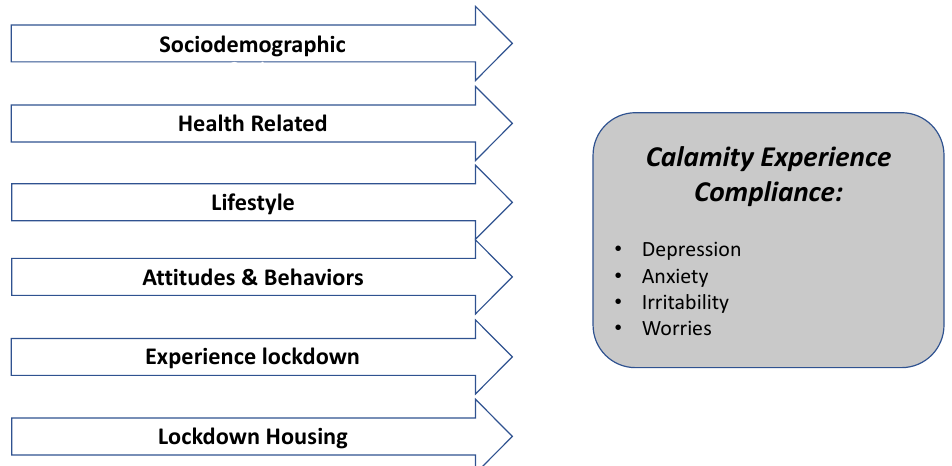
Figure 1. Ecological conceptual model resulting from the study.